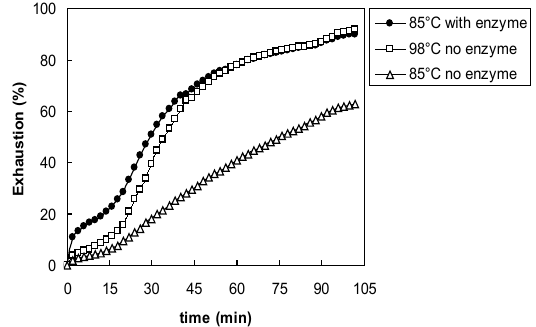
Figure 3. Exhaustion curves with dye triad on wool, with or without enzyme